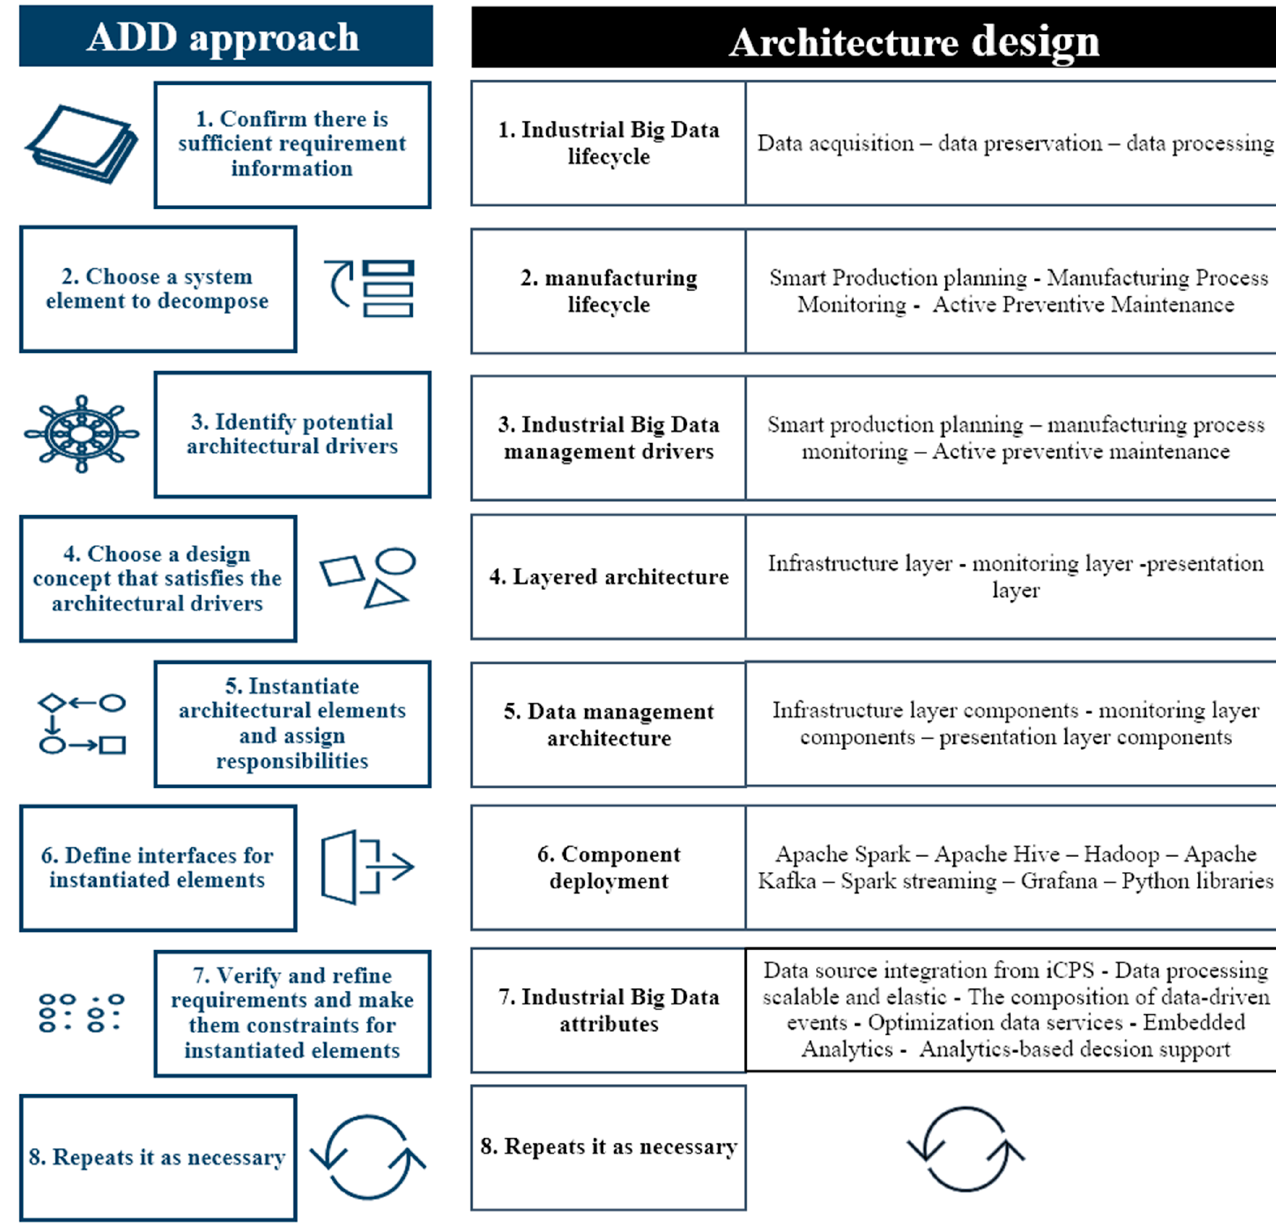
Figure 7. The process of attribute-driven design approach. ( Graphics source: image library of Microsoft Office).